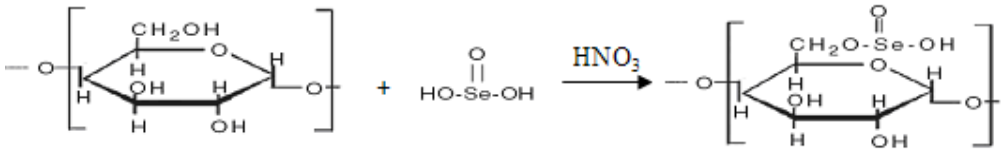
Figure 4. Selenylation mechanism of